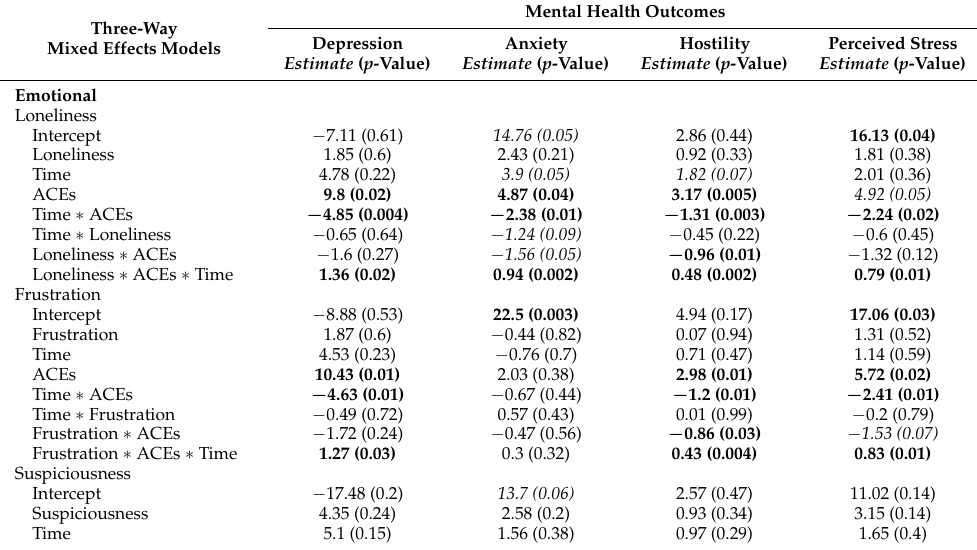
Table A2. Three-way Longitudinal Mixed Effects Models Predicting Changes in Mental Health Outcomes as a Result of The Interaction between COVID-19 Proximal Stressors and Exposure to ACEs Over